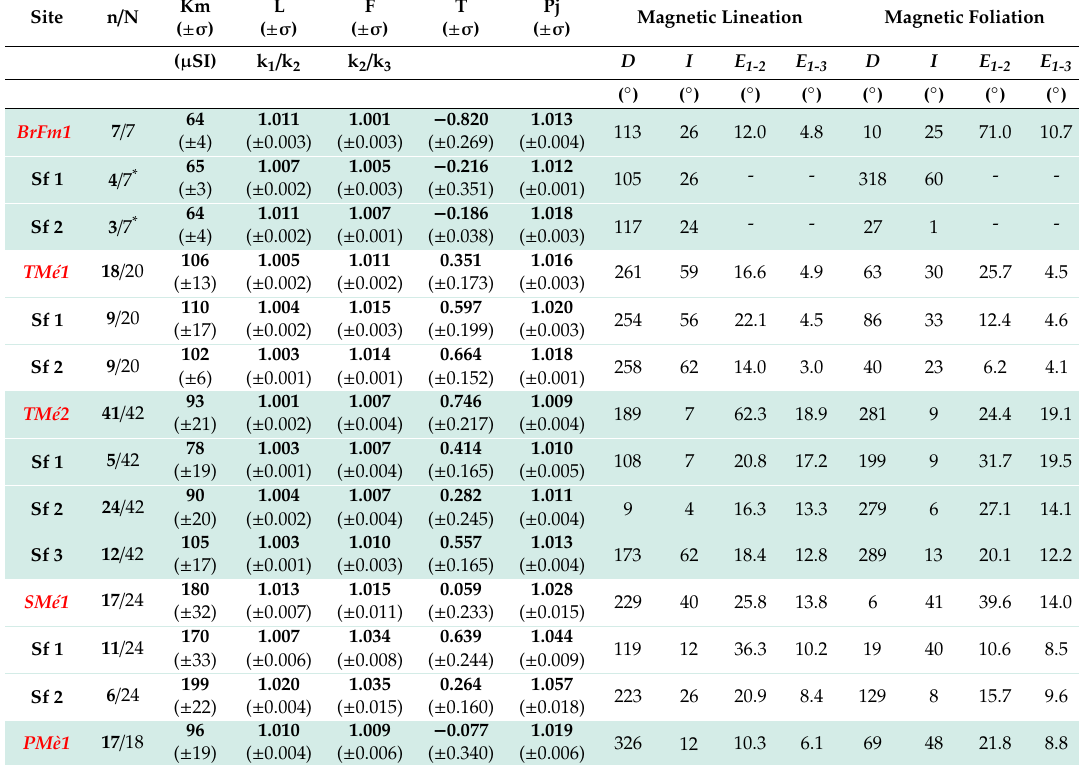
Table 1. Magnetic susceptibility and AMS data from broken formation (BrFm1), tectonic (TM é 1